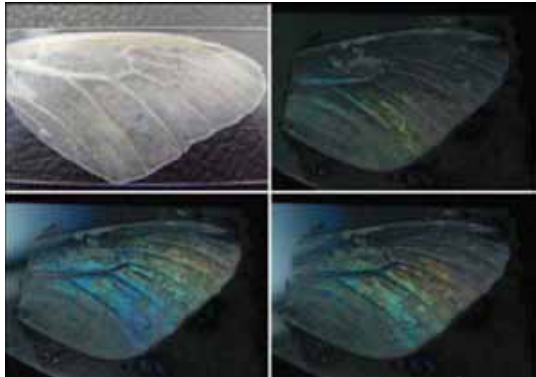
Fig. 7 Photographs of the original faded wing and the ZrO mineralized wing sample. a. The faded 2 wing. b. The ZrO replica in different observa- 2 tion angles.